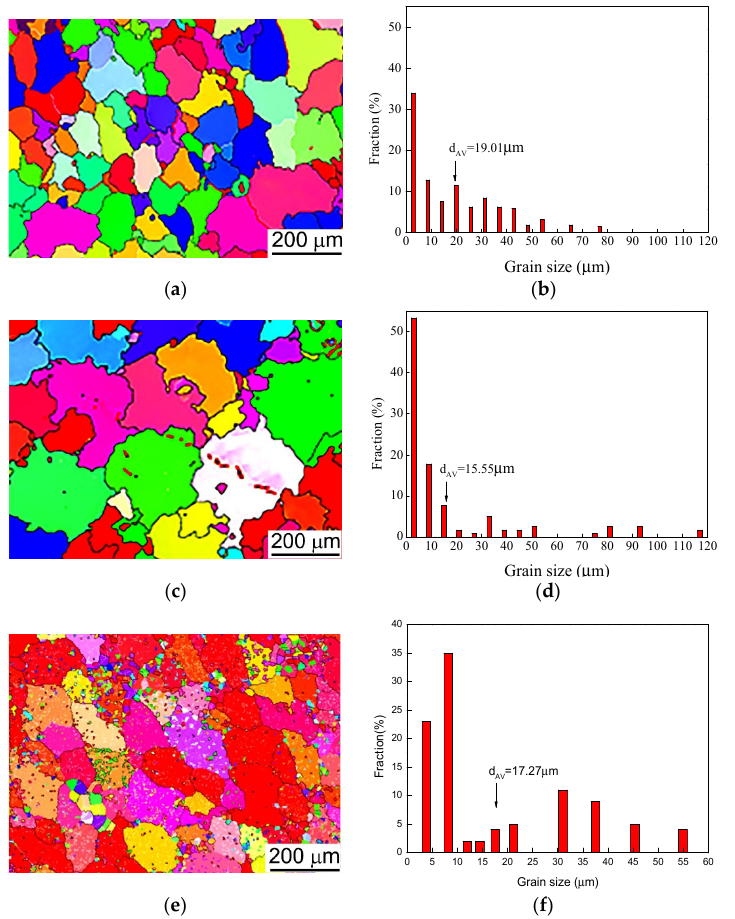
Figure 9. EBSD maps and grain size of weld metal with magnetic field. ( a , b ) 1 mg/cm 2 ; ( c , d ) 3 mg/cm 2 ; ( e , f ) 5 mg/cm 2 .